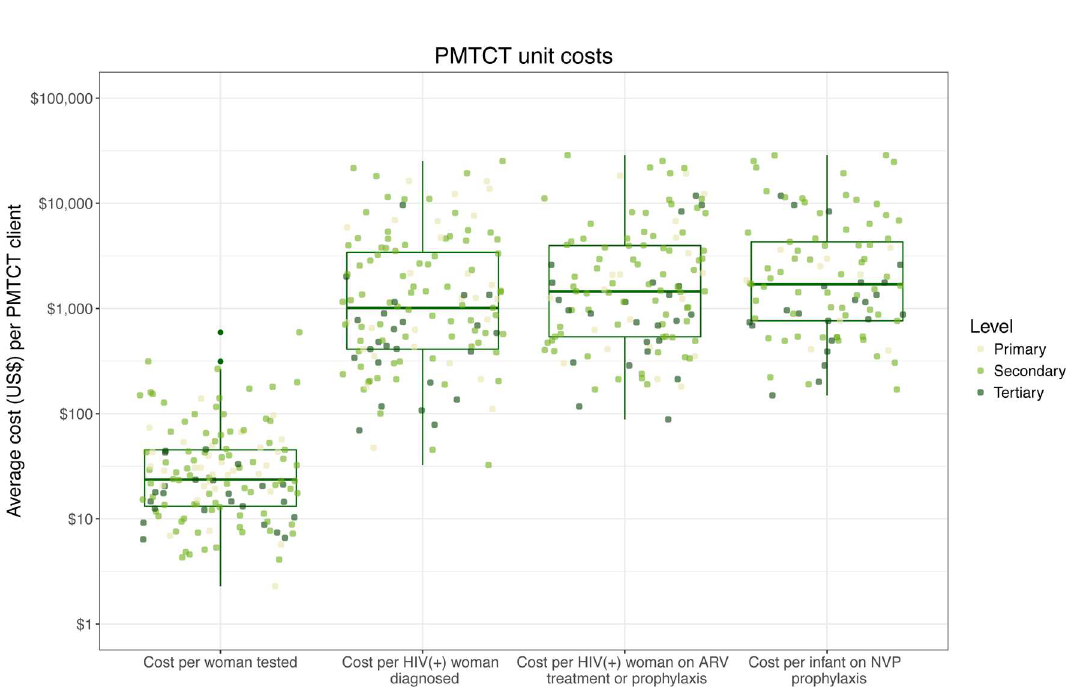
Fig 4. PMTCT average costs by cascade stage and level of care. Note: Lines inside the box indicate the median of the distribution; boxes depict the inter-quartile range (IQR); whiskers extend to 1.5 times the IQR.